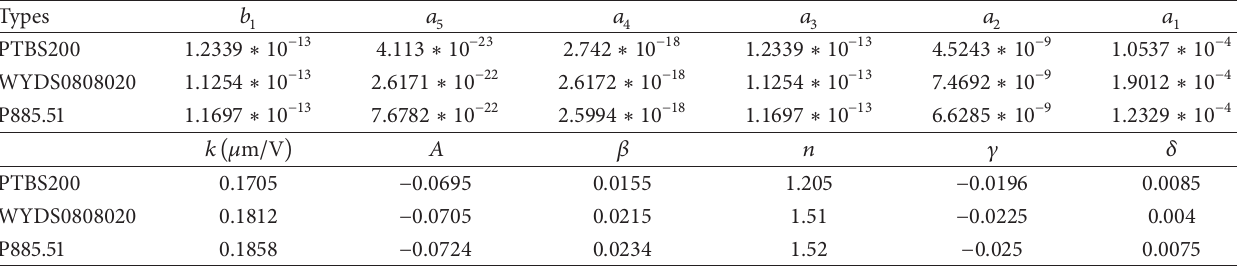
Table 1: Identified parameters of the modified comprehensive model.